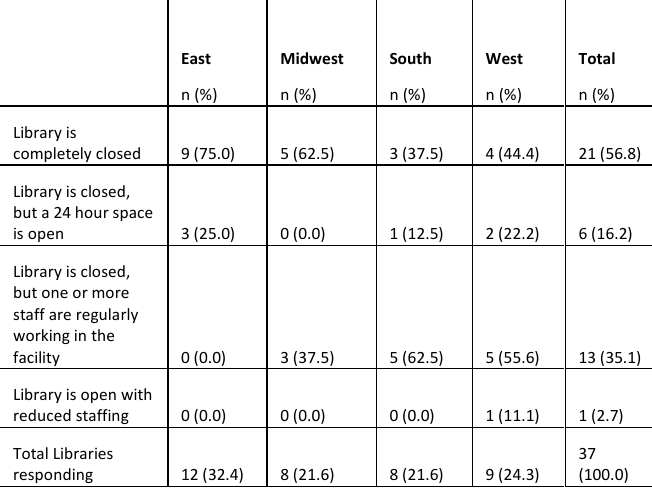
Table 1 April 2020 Library Status by Region.